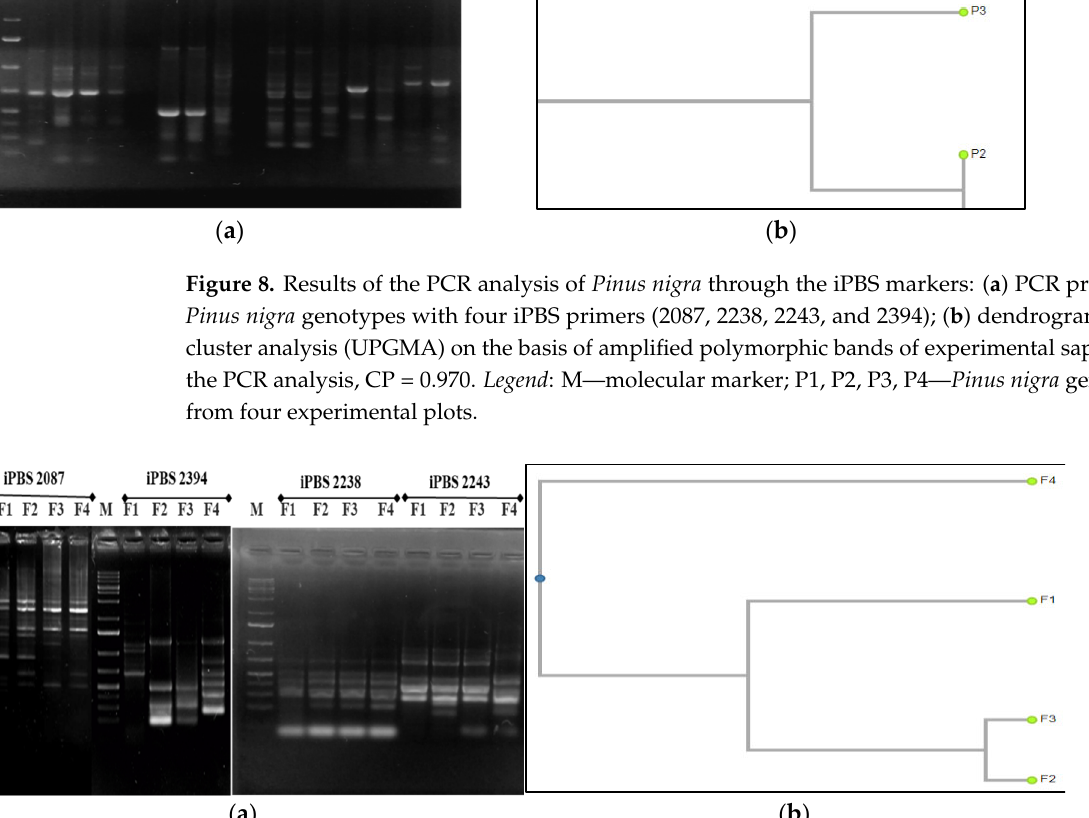
Figure 9. Results of the PCR analysis of F. excelsior through the iPBS markers: ( a ) PCR profiles of F. excelsior genotypes with four iPBS primers (2087, 2238, 2243, and 2394); ( b ) dendrogram of the cluster analysis (UPGMA) on the basis of amplified polymorphic bands of experimental saplings in the PCR analysis, CP = 0.971. Legend : M—molecular marker; F1, F2, F3, F4— F. excelsior genotypes from four experimental plots.